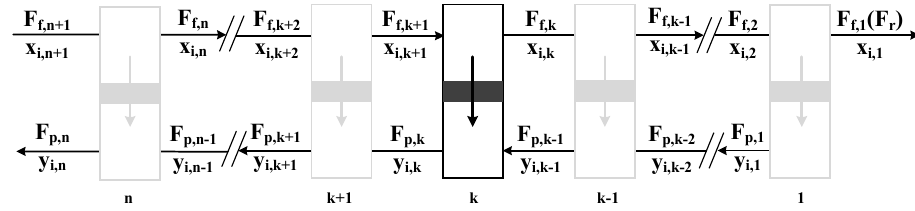
Figure 1. Schematic diagram of membrane unit model (counter ‐ current).